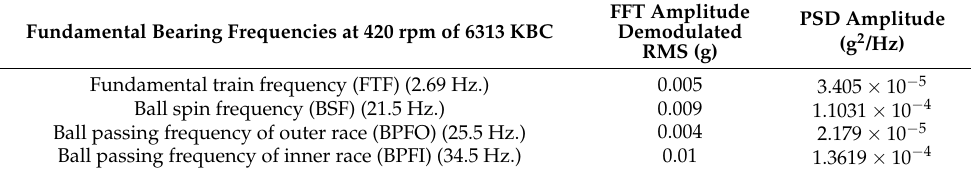
Table 7. Conversion from FFT to